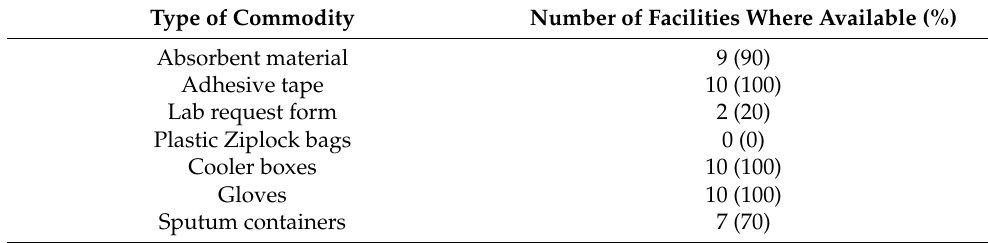
Table 3. Availability of material/equipment for collection and packaging of sputum specimens in ten non-diagnostic centers in Mpulungu District (October